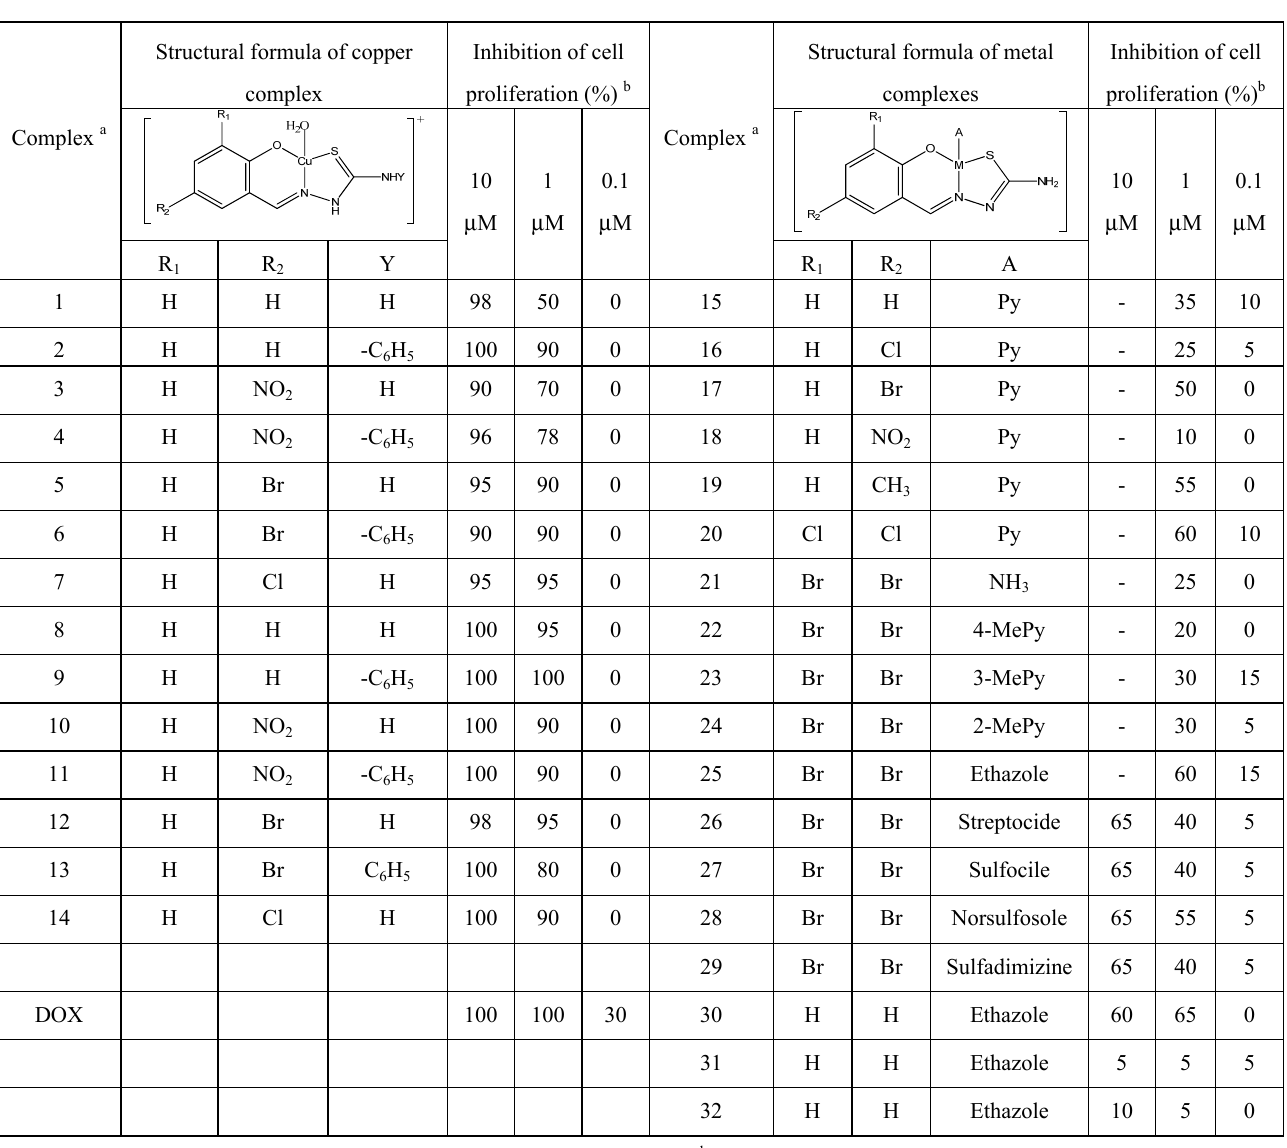
Table 4. Antiproliferative activity of complexes 1 – 32 on human leukemia (HL-60) cells at three